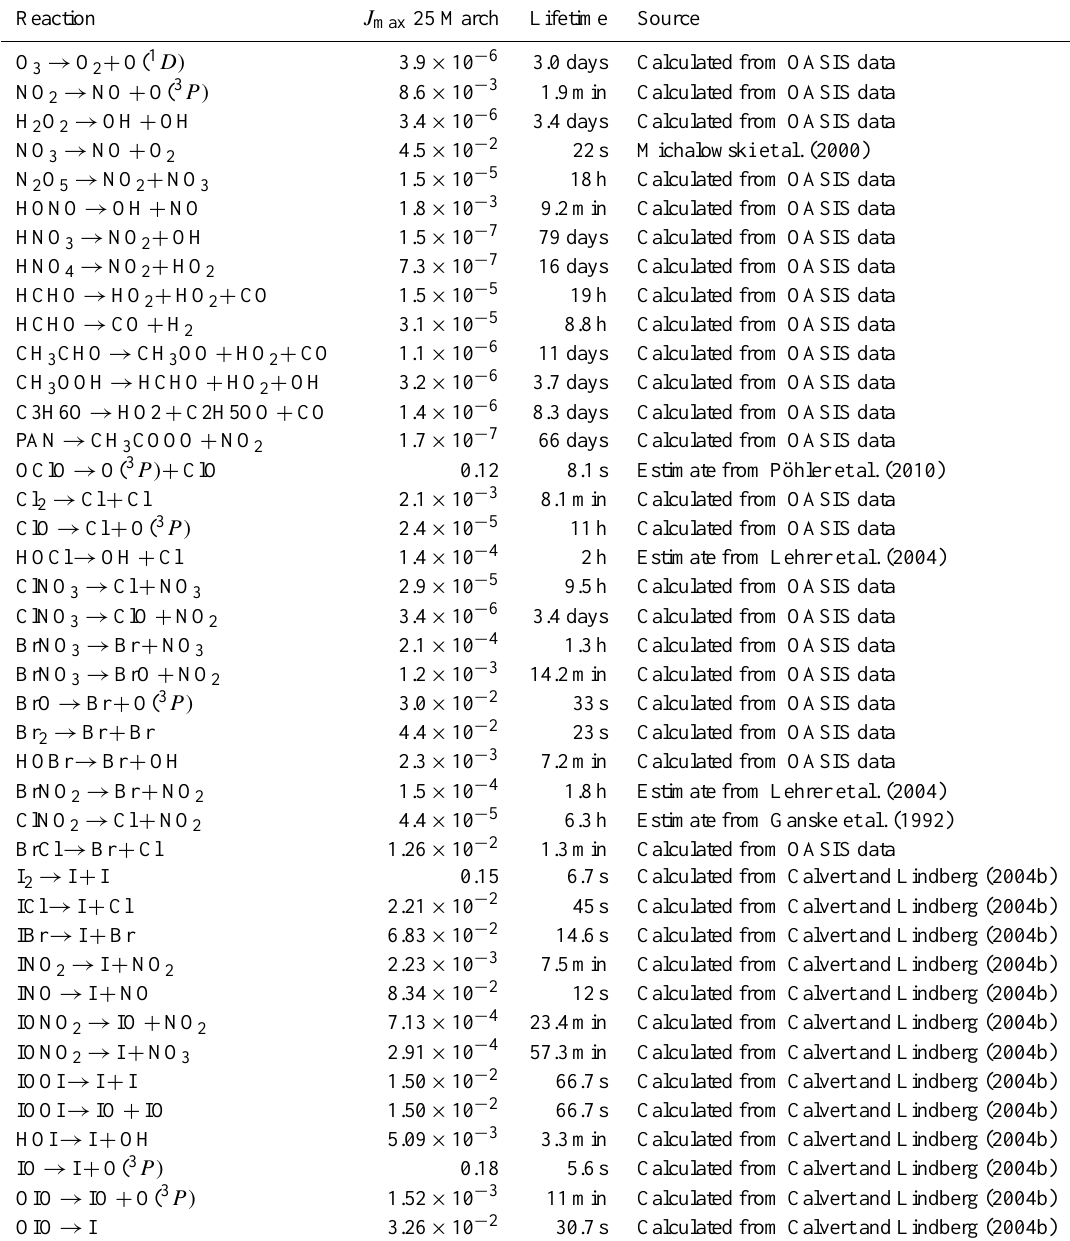
Table 2. Photochemical reactions. J max values for 25March are shown as an example. J coefficients are expressed in units of s − 1 .